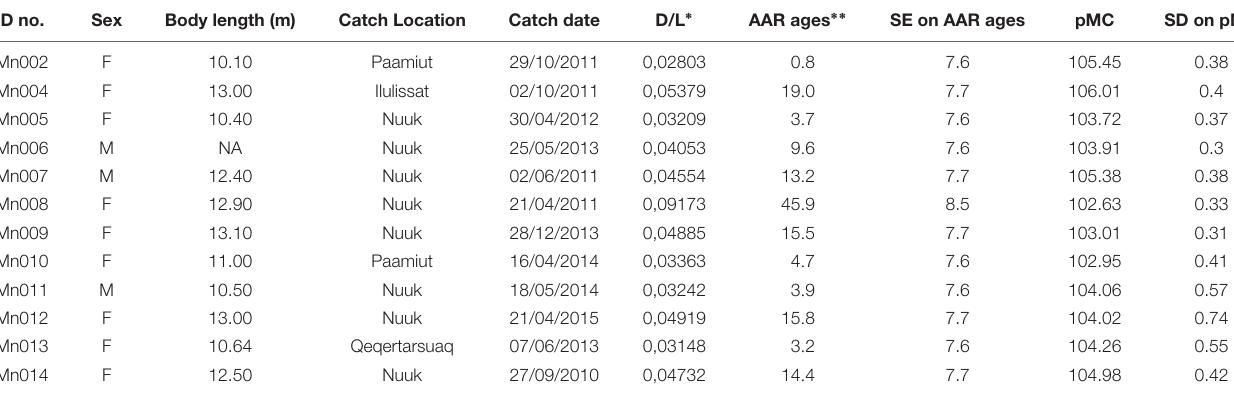
TABLE 1 | Information and calculated ages on the 12 sampled humpback whales. ID